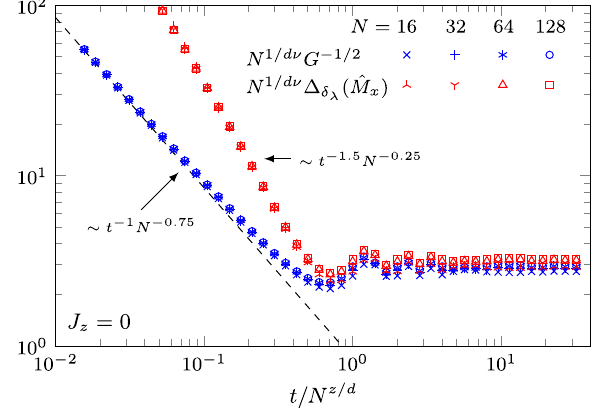
FIG. 2. Time dependence of QFI at the critical point in the XXZ model. Results from a small external magnetic field change as in Eq. (13). The time is rescaled by the system size according to Eq. (15). QFI (blue symbols) is rescaled corresponding to the FIG. 1. XXZ model in the external field, Eq. (21). (a) Scaling of ˆ M adiabatic limit given by Eq. (11). Here, for J the error propagation formula for operators and ˆ m , and the x x d ν ¼ 4 = 7 . For evolution times t ≫ N z=d we recover the adiabatic ultimate bound given by inverse of QFI, as a function of the ˆ M limit. For short times G 1 = 2 ∼ tN 1 − ½ h (cid:2) =d , which is marked with system size. The error propagation formula for closely x dashed line. In our case, 1 − ½ h (cid:2) =d ¼ 3 = 4 . We also show the time follows the ultimate bound. Dashed lines indicate the slopes corresponding to the expected scaling and serve as guidance for dependence of the precision allowed by Þ − 1 = 2 ∼ N − 1 . 74 , Δ ð ˆ M Þ ∼ N − 1 . 73 , error propagation formula (red symbols). For long time, in the ; λ the eye. The fits give G ð λ δ λ c x c ð ˆ m Þ ∼ N − 1 . 49 , where the expected exponents are 1.75, adiabatic limit, it is almost optimal and nearly saturates QFI. For ; λ and Δ δ x c λ ¼ 0 and the fits were done short times it is suboptimal. In that case Δ δ 1.75, and 1.5, respectively. Here, J z t − 1 . 5 N − 0 . 25 is below the shot-noise limit as a function of N , for N ¼ 128 − 256 [76]. (b) In the considered model the scaling exponents in Eqs. (11), (17), and (18) depend continuously on the see Eq. (25), a result of strong fluctuation at the critical value of parameter J , following Eq. (22). We compare those z predictions with numerical results obtained similarly as in (a). The exponent associated with the standard Heisenberg limit is marked with the dashed line for comparison. Its apparent breaking is the main subject of this article.